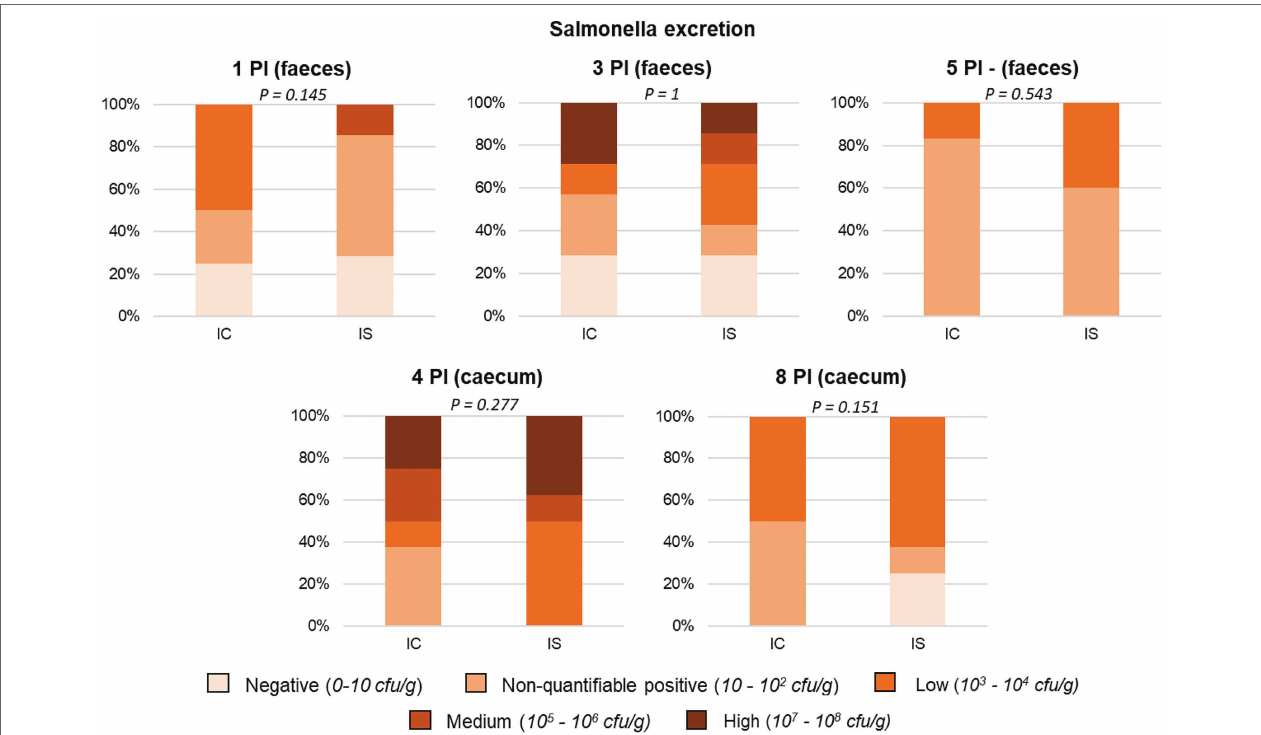
FIGURE 2 | Percentage of animals included in the different faecal and caecal excretion levels of Salmonella . All samples were obtained from the heaviest animal in each pen, except for the caecal sample on day 4 PI, which was obtained from the anima of medium weight. IC, inoculated animals receiving placebo; IS, Inoculated animals receiving the synbiotic; and N = 8 for IC and IS. Values of p were obtained using Fisher’s Exact Test on R software.